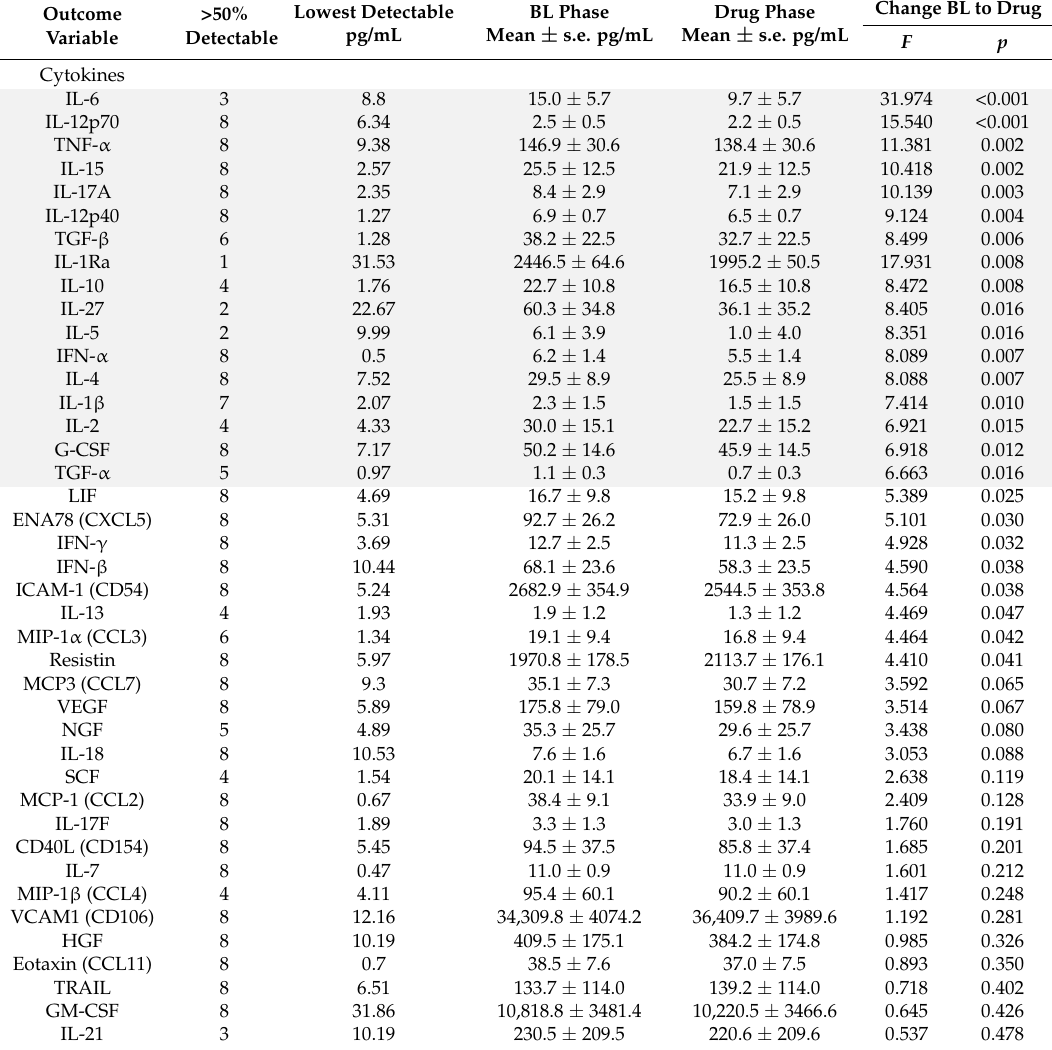
Table 2. Study primary outcomes (cytokines) and secondary outcomes (pain and overall symptoms). All tested cytokines are arranged in order of increasing p -values; those found to be significant at the corrected α = 0.017 are highlighted in gray. As a test of generalizability, column two indicates the number of individuals who expressed higher than the lowest detectable concentration (column three) in at least 50% of their collected samples. Columns four and five show the mean (and standard error) of the cytokine concentrations at the two key study time points. The last two columns show the results of the linear mixed models (LMM) analyses. IL = interleukin, TNF = tumor necrosis factor, TGF = transforming growth factor, IFN = interferon, G-CSF = granulocyte-colony stimulating factor, LIF = leukemia inhibitory factor, ENA = epithelial-derived neutrophil-activating peptide, ICAM = intercellular Adhesion Molecule, MIP = macrophage inflammatory protein, MCP = monocyte chemoattractant protein, VEGF = Vascular endothelial growth factor, NGF = nerve growth factor, SCF = stem cell factor, CD = cluster of differentiation, VCAM = vascular cell adhesion molecule, HGF = hepatocyte growth factor, TRAIL = TNF-related apoptosis-inducing ligand, GM-CSF = granulocyte macrophage colony-stimulating factor, PIGF = placental growth factor, IP = interferon γ -induced protein, PAI = plasminogen activator inhibitor, EGF = epidermal growth factor, RANTES = regulated on activation, normal T cell expressed and secreted, SDF = stromal cell-derived facto, BDNF = brain-derived neurotrophic factor, PDGF = platelet-derived growth factor, MIG = monokine induced by gamma interferon, GRO- α = growth regulated α protein, MCSF = macrophage colony stimulating factor, FGF = fibroblast growth factor , FasL = fas ligand, s.e. = standard